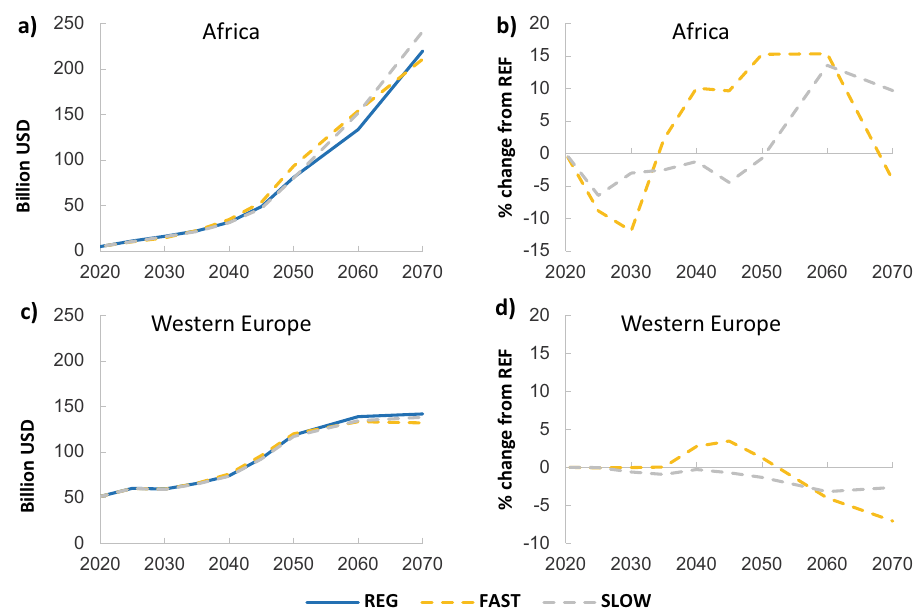
Fig. 5 Investment levels in low-carbon electricity for the 2 °C scenarios with different WACCs reduction rates. The left-hand panels show investment levels (Billion USD) in low-carbon electricity for the 2 °C scenarios with different WACCs reduction rates for ( a ) Africa and ( c ) Western Europe. The right hand panels show percentage changes in low-carbon investment compared to the REG scenario for ( a ) Africa and ( d ) Western Europe.